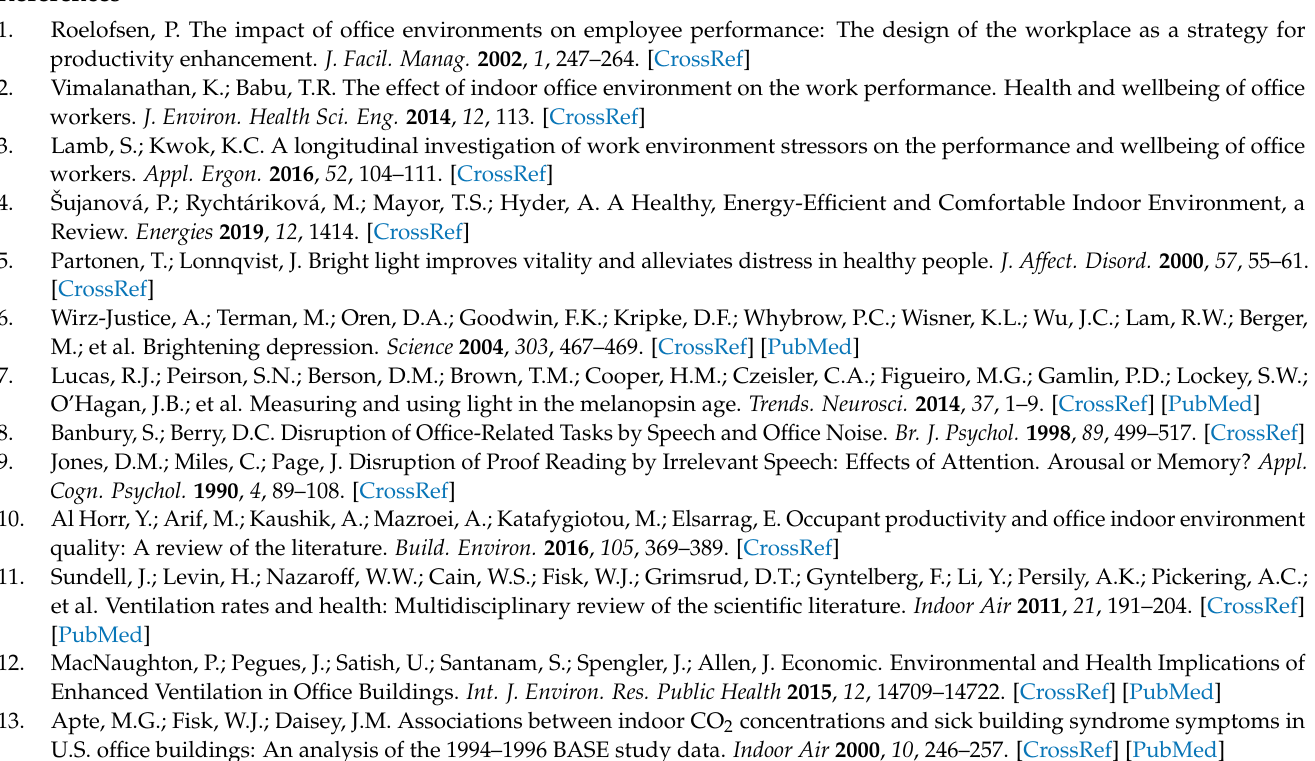
Figure A2. Symbol legend for the Comfort Map